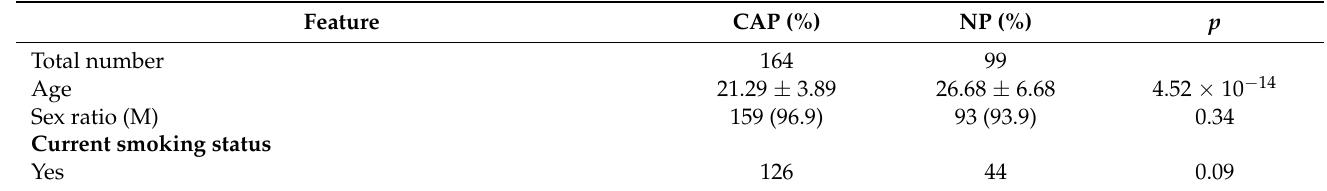
Table 1. Characteristics of the CAP and NP groups.